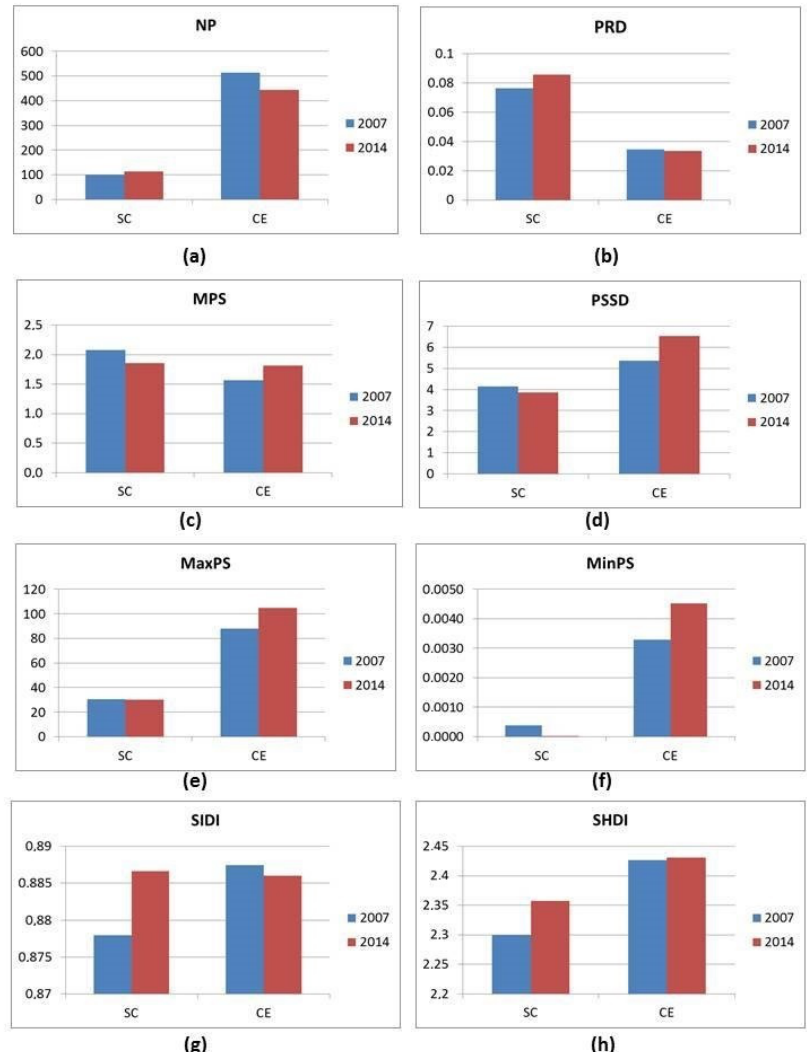
Figure 17. Barplots comparing the landscape metrics at landscape level (( a ) NP; ( b ) PRD; ( c ) MPS; ( d ) PSSD; ( e ) MaxPS; ( f ) MinPS; ( g ) SIDI; ( h ) SHDI), calculated on the basis of the EUNIS map, at the two sites in the two years of observation.